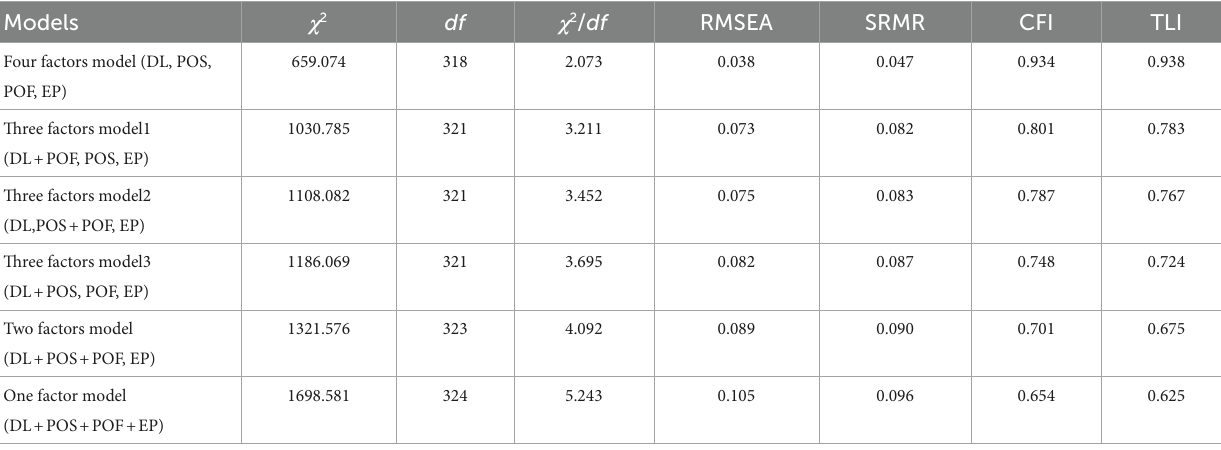
TABLE 1 Confirmatory factor